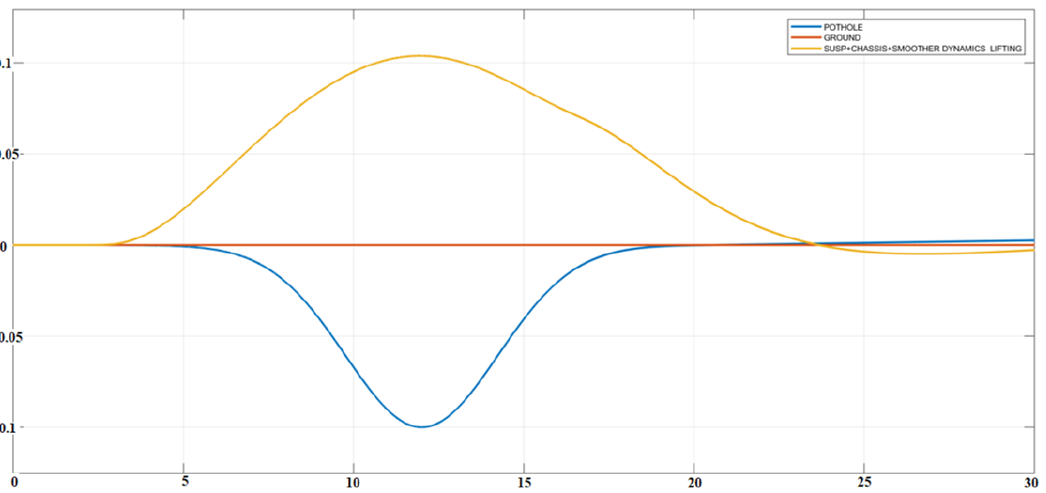
Figure 11. Controlled action to elevate the structure of the vehicle before falling in a pothole that was modeled by a Gaussian